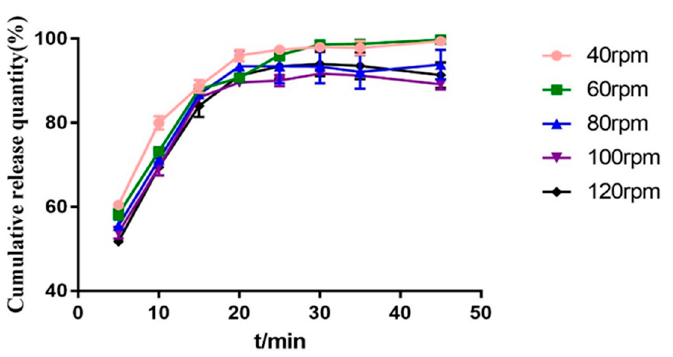
Figure 12. Dissolution curves of solid dispersions prepared at different screw speeds.